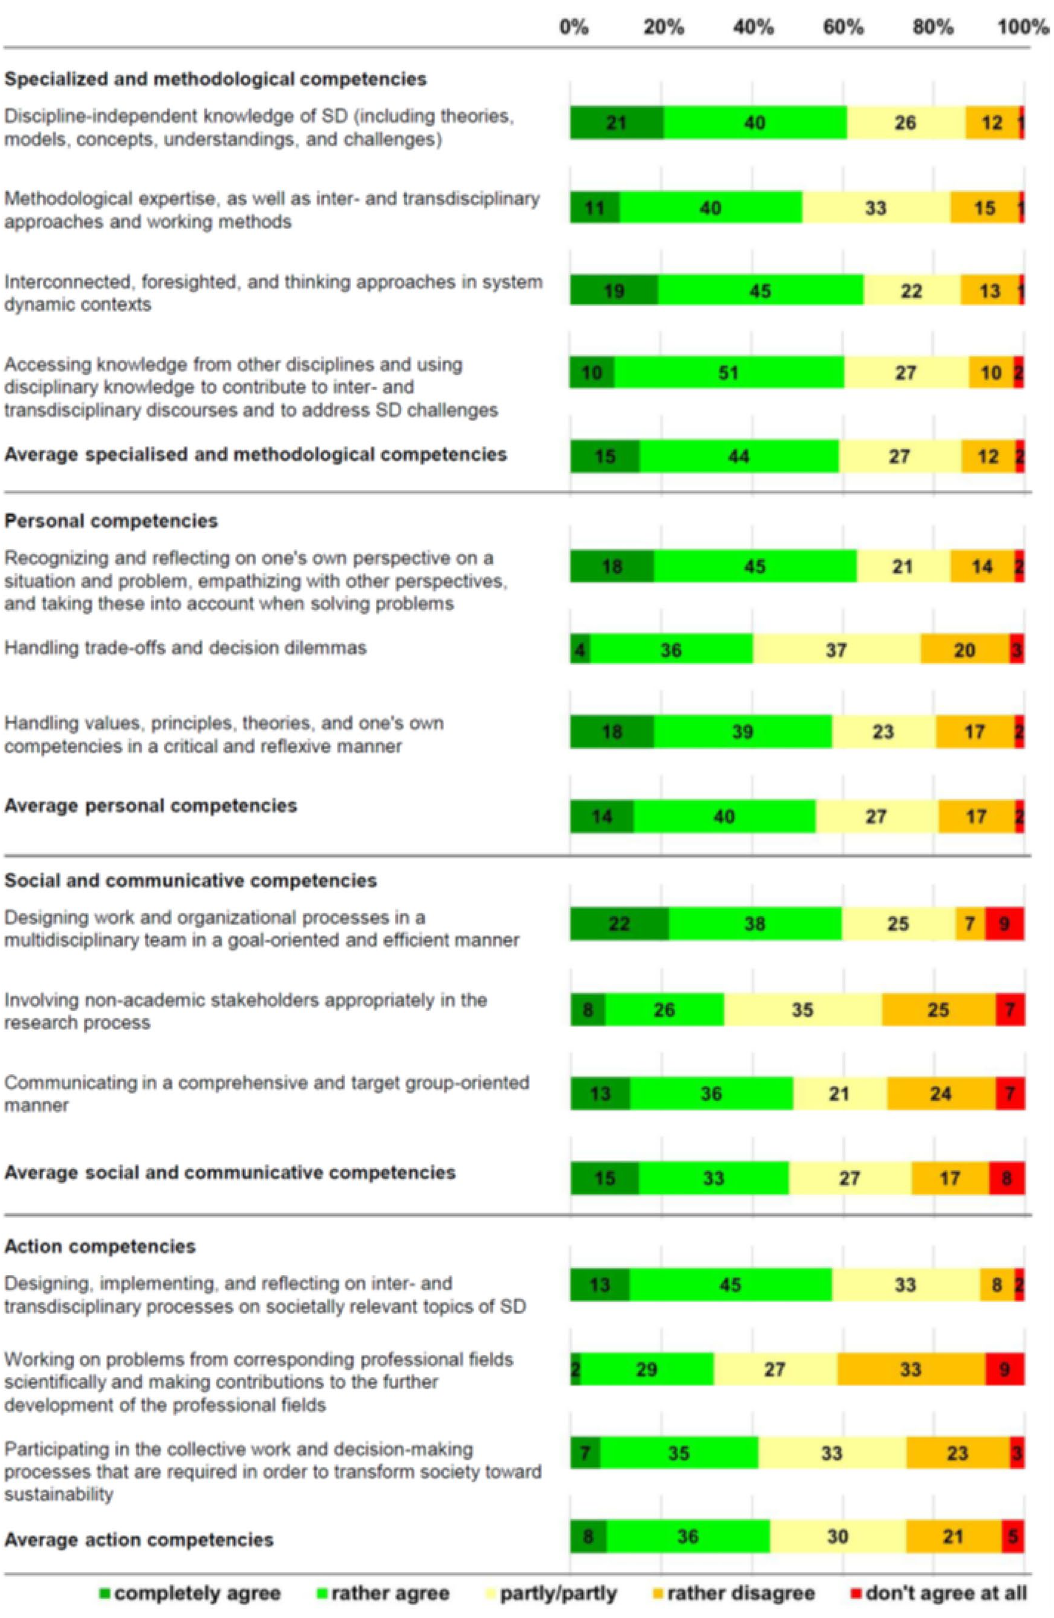
Fig. 11 Assessment of the graduates regarding the acquisition and enhancement of competencies during the SD study program (N =